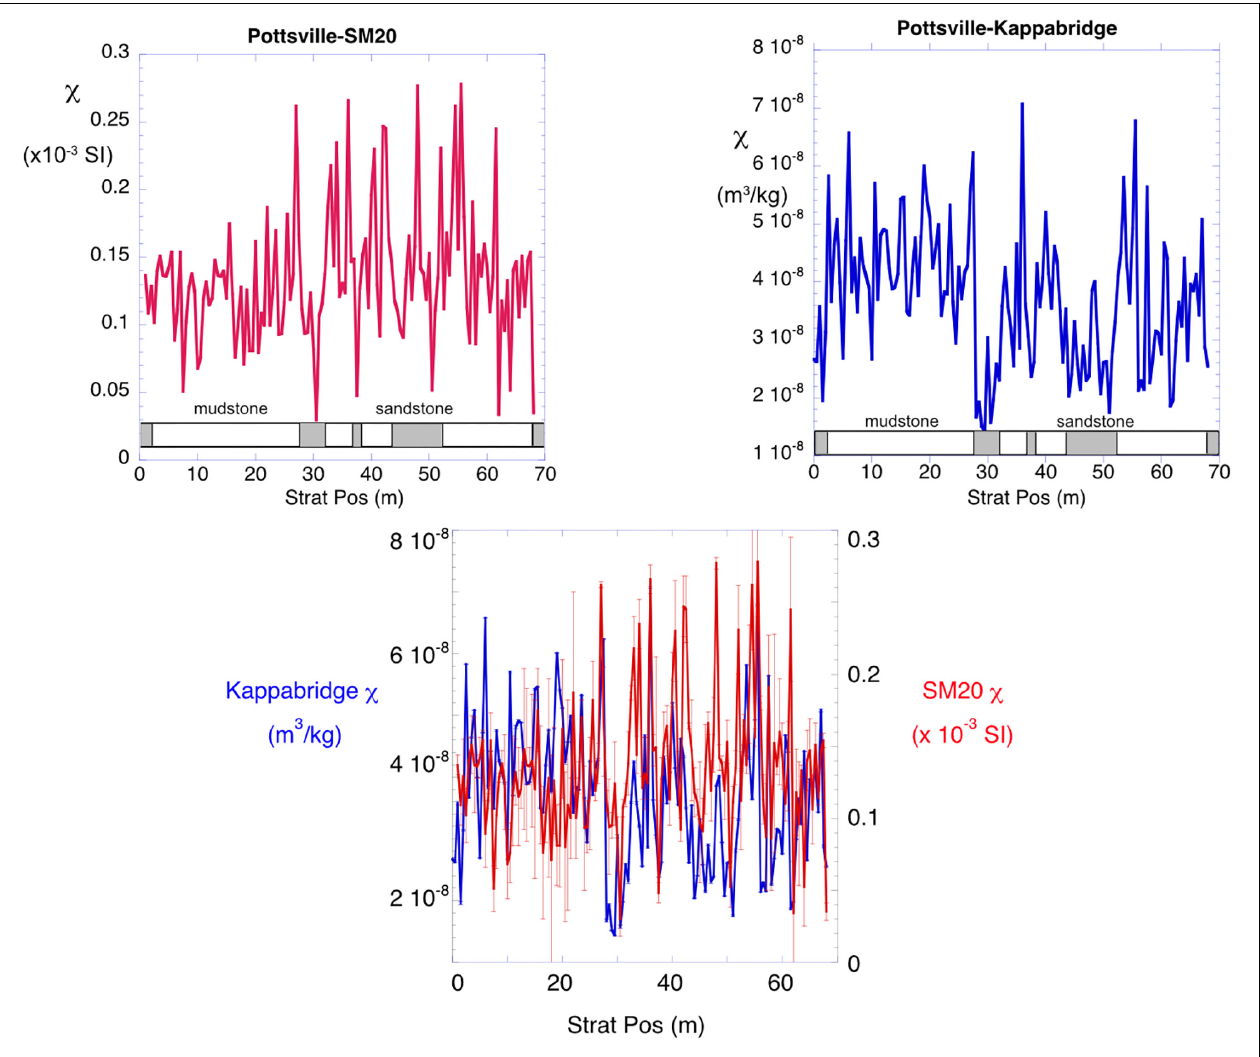
FIGURE 3 | Time series magnetic susceptibility for 68 m of the Pottsville section measured by the SM-20 portable susceptibility meter (Top left) and for rock samples collected in the field and measured on the Kappabridge KLY-3s at the Lehigh University (Top right) . Below each plot is the stratigraphy for the 68 m samples showing the sandstone channel deposits and the mudstone overbank deposits. Base of the section is to the left. Both time series show both long period and short period variability; however, they do not match. The Kappabridge measured susceptibility shows better correlation to the lithologic variations at long periods, but both time series show short period variations within the different lithologies. A direct comparison of the two time series (Bottom center) , with one standard deviation error bars, shows the high uncertainty in the SM-20 measurements compared to the low uncertainty in the Kappabridge measurements (error bars are typically smaller than the symbol for the